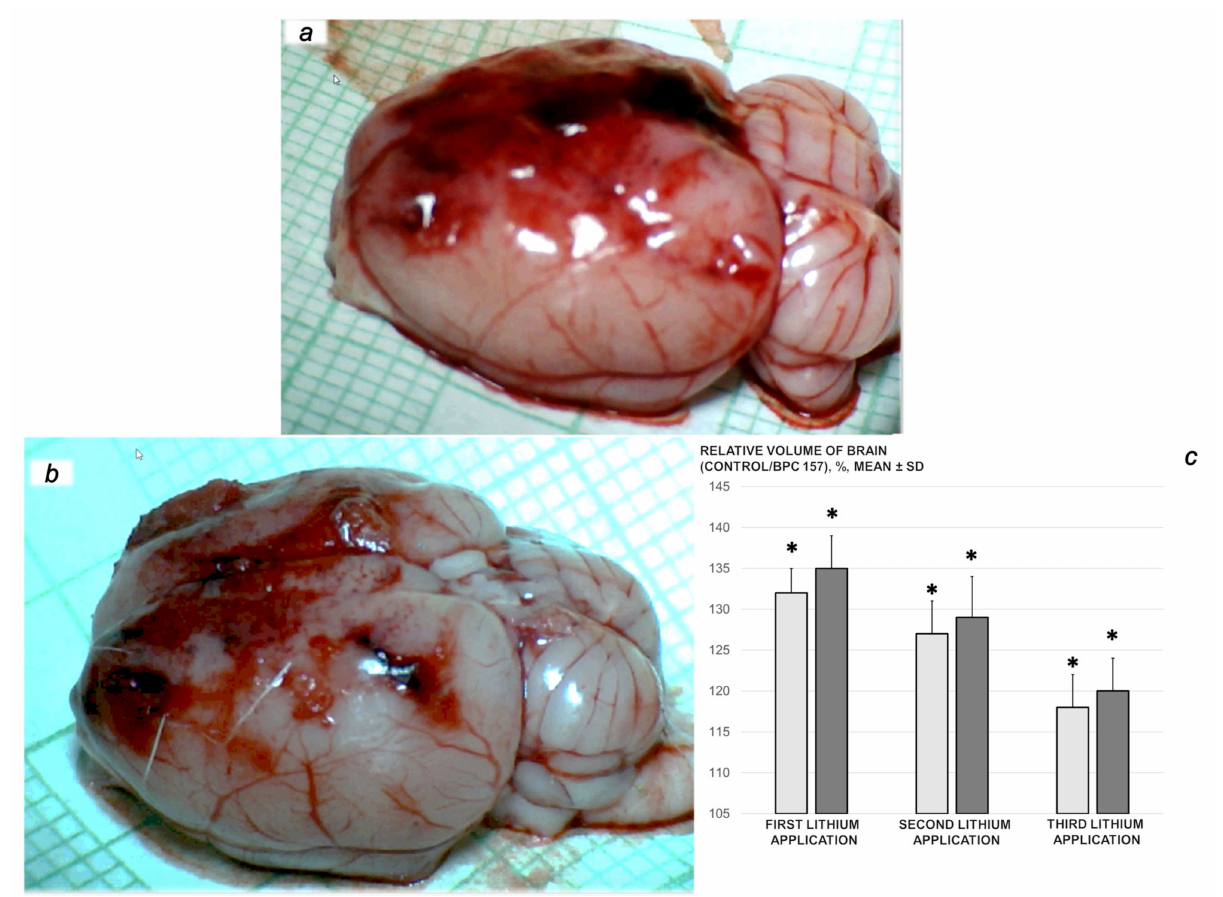
Figure 12. Brain gross presentation immediately after sacrifice in rats that received third lithium administration and BPC 157 ( a ) or saline ( b ) as therapy. ( c ) Relative volume of the brain, volume control/volume BPC 157, %, in the rats that received the first, second, and third lithium administration (500 mg/kg/day intraperitoneally for 3 consecutive days). BPC 157 10 µ g/kg (light gray bars), 10 ng/kg (dark gray bars); saline 5 mL/kg (white bars) given intraperitoneally after each of the three lithium sulphate administrations. Six rats/group/interval. Means ± SD, * p < 0.05, at least, vs.